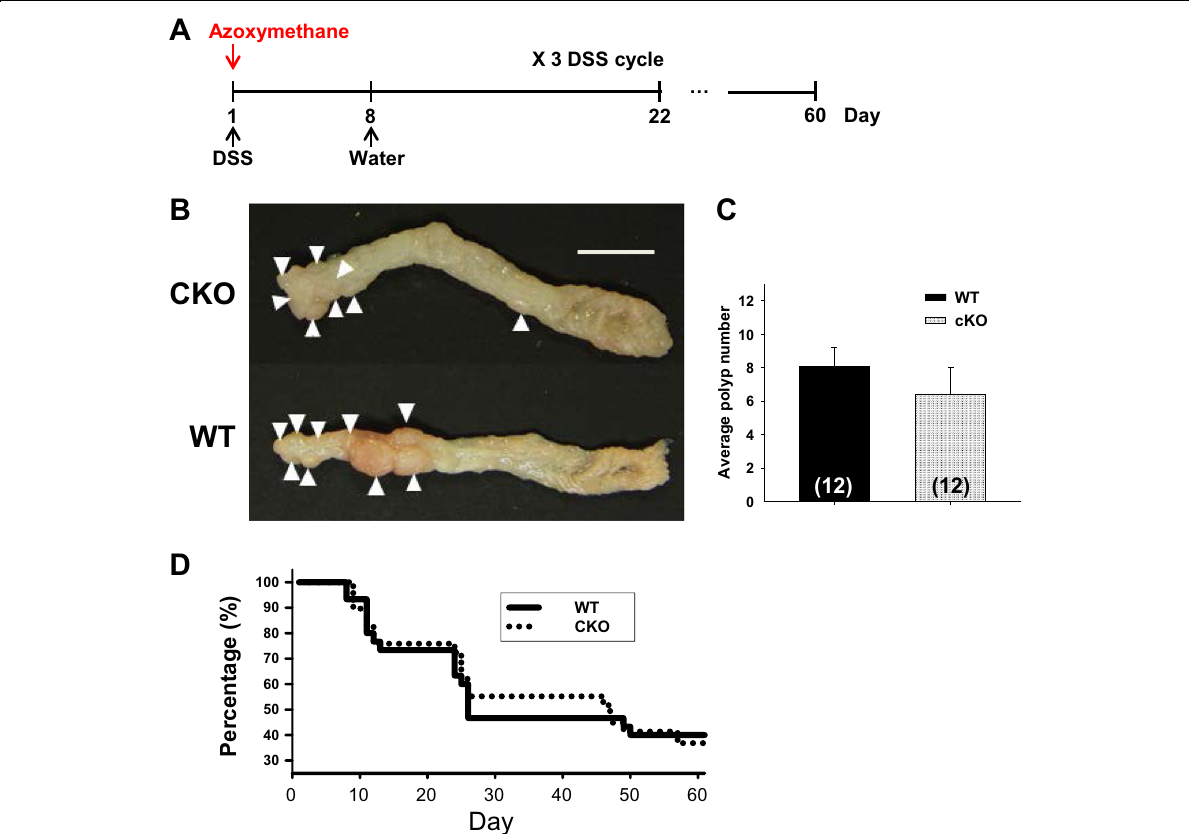
Fig. 7 Ano1 -de fi cient colons were not susceptible to colorectal cancer. a Schematic protocol for the model of colorectal cancer induced by azoxymethane and DSS. After the intraperitoneal injection of azoxymethane (10 mg/kg), 2% DSS was given in drinking water for 8 days. The mice then recovered for 14 days. The DSS treatment cycle was repeated three times, and the mice were sacri fi ced on day 60. b Colons of Ano1 fl / fl (WT) and Cdx2-Ano1 fl / fl (CKO) mice after treatment with azoxymethane and DSS. Polyps are indicated by arrowheads. c , d Number of polyps ( c ) and incidence of death ( d ) in WT ( n = 29) and CKO ( n = 30) mice after treatment with azoxymethane plus